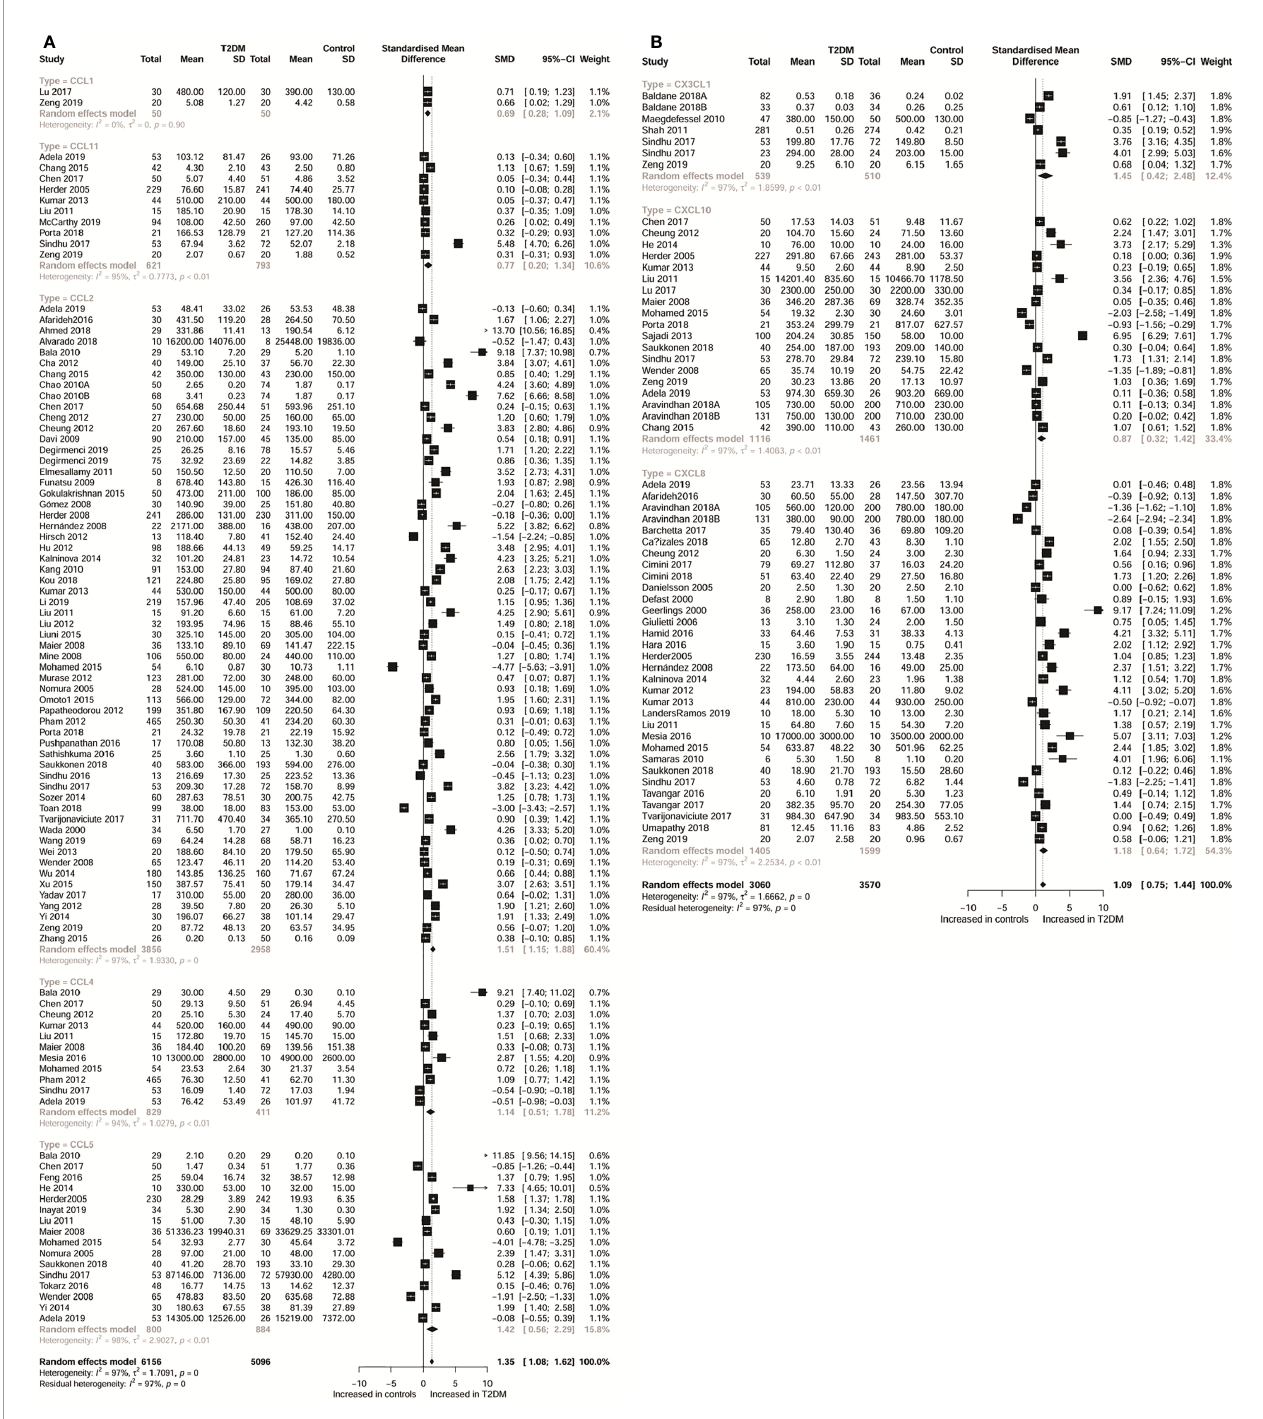
FIGURE 1 | Forest plot of CC chemokine (A) and CXC chemokine (B) between T2DM patients and controls. Study effect sizes of chemokines differences between T2DM and controls. Each data marker represents a study, and the size of the data marker is proportional to the total number of individuals in that study. The summary effect size for each chemokines is denoted by a diamond. T2DM, type 2 diabetes mellitus; SMD, standardized mean